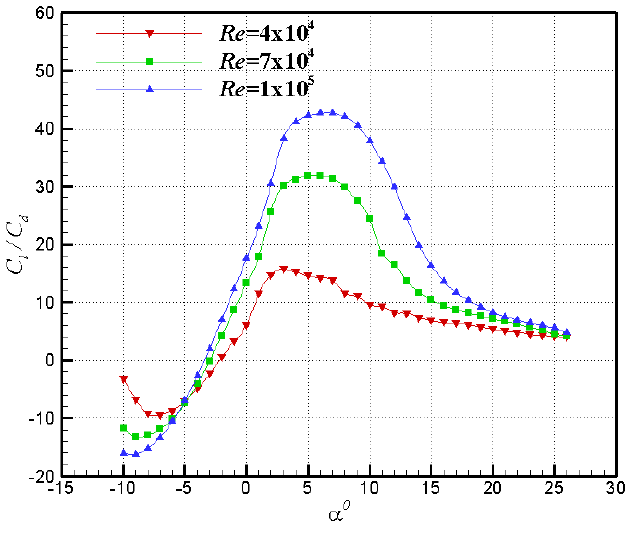
= 1.0 for the BEM crit